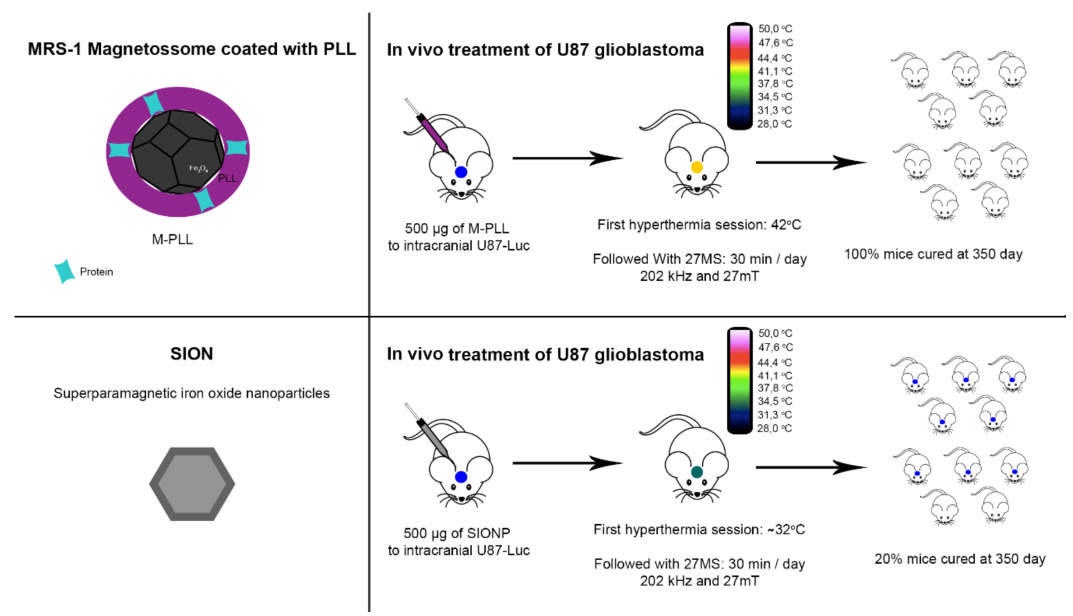
Figure 8. Illustrative scheme of cancer hyperthermia therapy research protocols using magnetosome magnetite crystals [104]. Magnetosomes coated with poly- L -lysine (PLL) without membrane (M-PLL) presented an antitumor effect in intracranial U87-Luc tumors in mice. This effect was observed after treatment of mice with 500 µ g of M-PLL followed by 28 magnetic sessions (MS) 30 min/day with 202 kHz and 27 mT. In this case, hyperthermia induced a temperature increase, reaching 42 ◦ C. After 350 days of the first exposure, tumors were eliminated in 100% of the treated mice. In contrast, the same treatment using superparamagnetic iron oxide nanoparticles (SION) resulted in a less effective increase of temperature and only 20% mice had tumors eliminated after 350 days